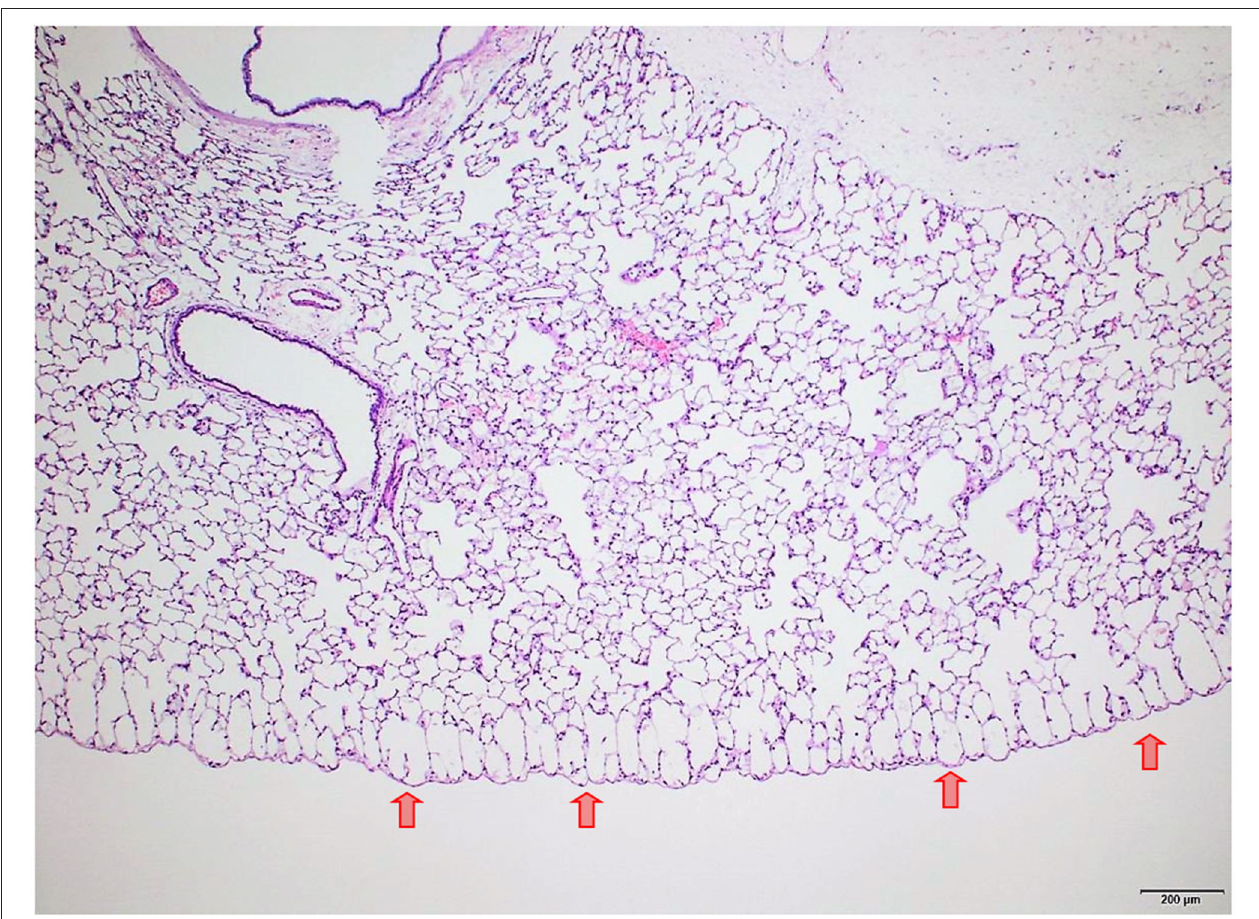
FIGURE 8 | Male rat. Deceased 3 ¼ h after inhalation start. Lung, left lobe. Focal subpleural acute emphysema (arrows). HE, original magnification